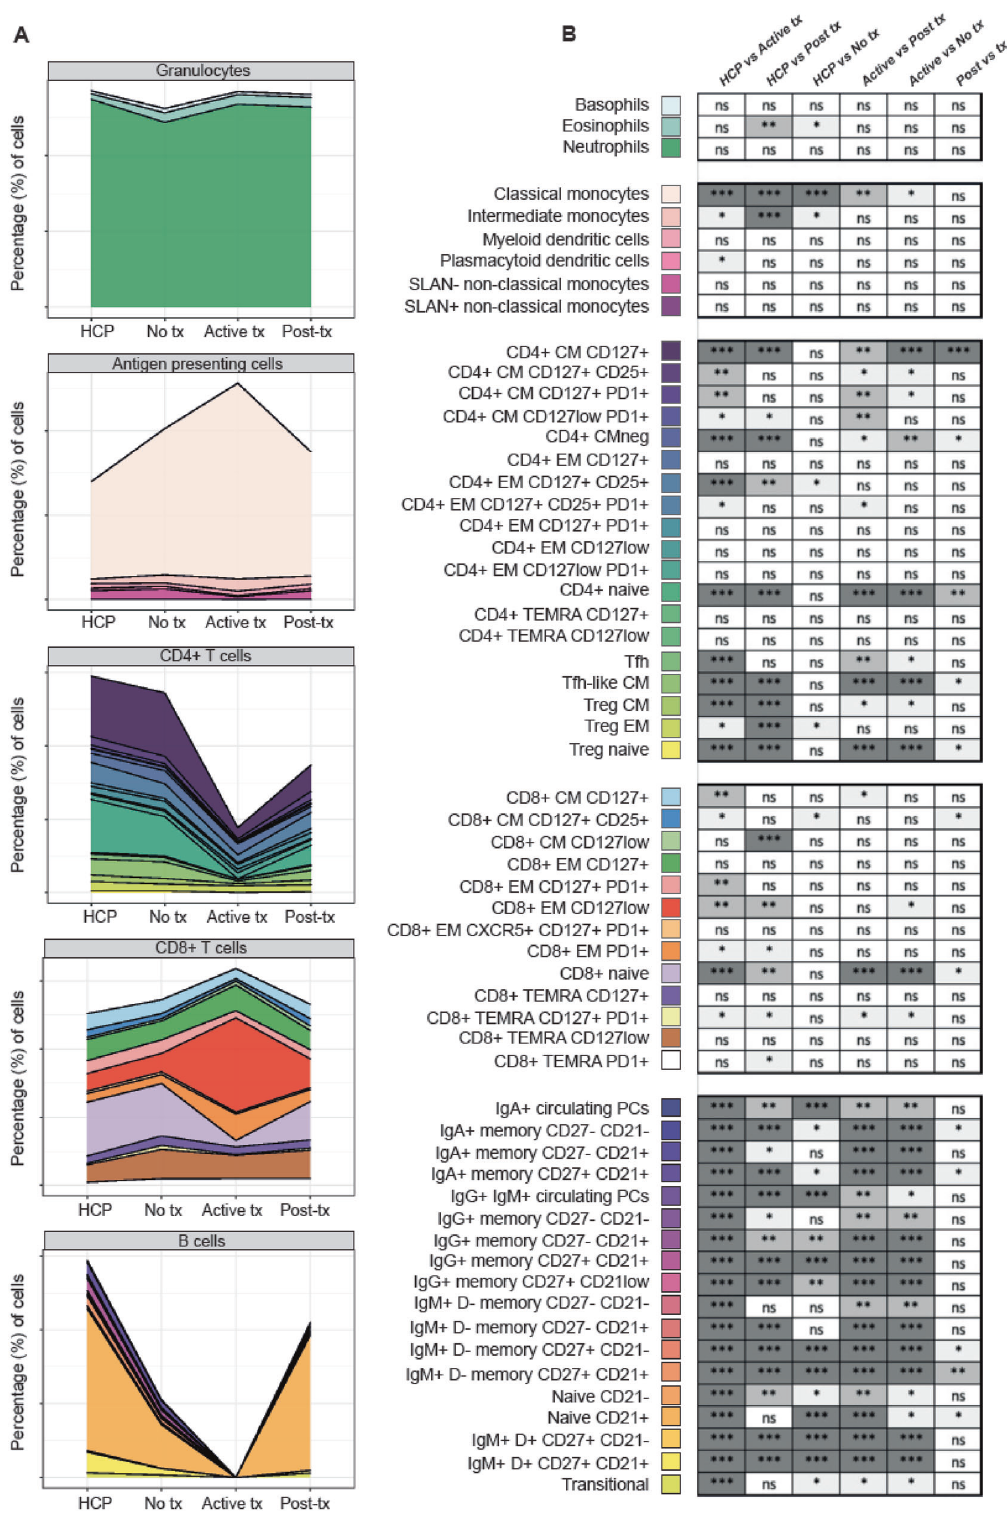
Fig. 3 Tumor-related immune dysregulation and therapy-related immunosuppression. A Relative distribution of granulocytes, antigen- presenting cells (APC), CD4 and CD8 T cells, and B cells across health care practitioners (HCPs), hematological patients that had never received treatment (No tx, N = 17), those that were on (Active tx, N = 17), and patients that were off-treatment (Post-tx, N = 49) before vaccination. B Statistical signi fi cance of differences across groups (with graphical representation of such differences in Supplemental Fig. 3). APC, antigen- presenting cells; CM, central memory; EM, effector memory; Treg, T regulatory cells; Tfh, T follicular-like; TEMRA, terminally effector memory CD45RA + ; PC, plasma cells. * P < 0.05; ** P < 0.01; *** P < 0.001; n.s., not signi fi